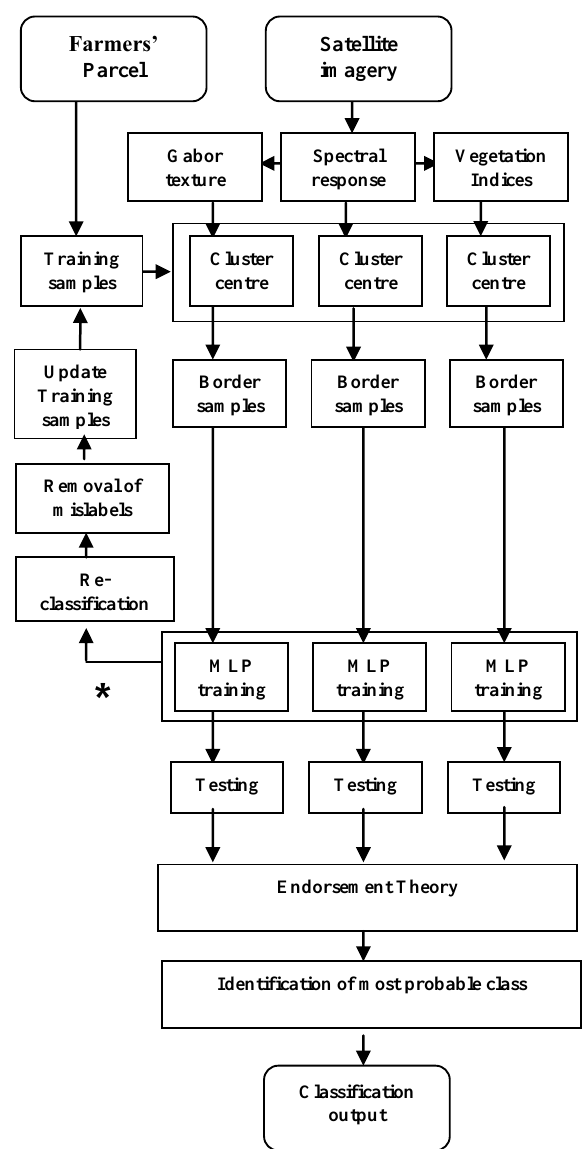
Figure 1. Work flow of ECRA for Endorsement Theory based classification ( * denotes the stopping criteria of the loop. The re-classification process is stopped once the cluster centres in three domains remains same as cluster centres in the previous iteration